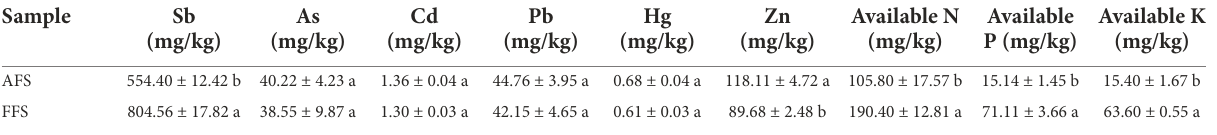
TABLE 1 Heavy metal and soil nutrients in the FFS and the AFS. Sample